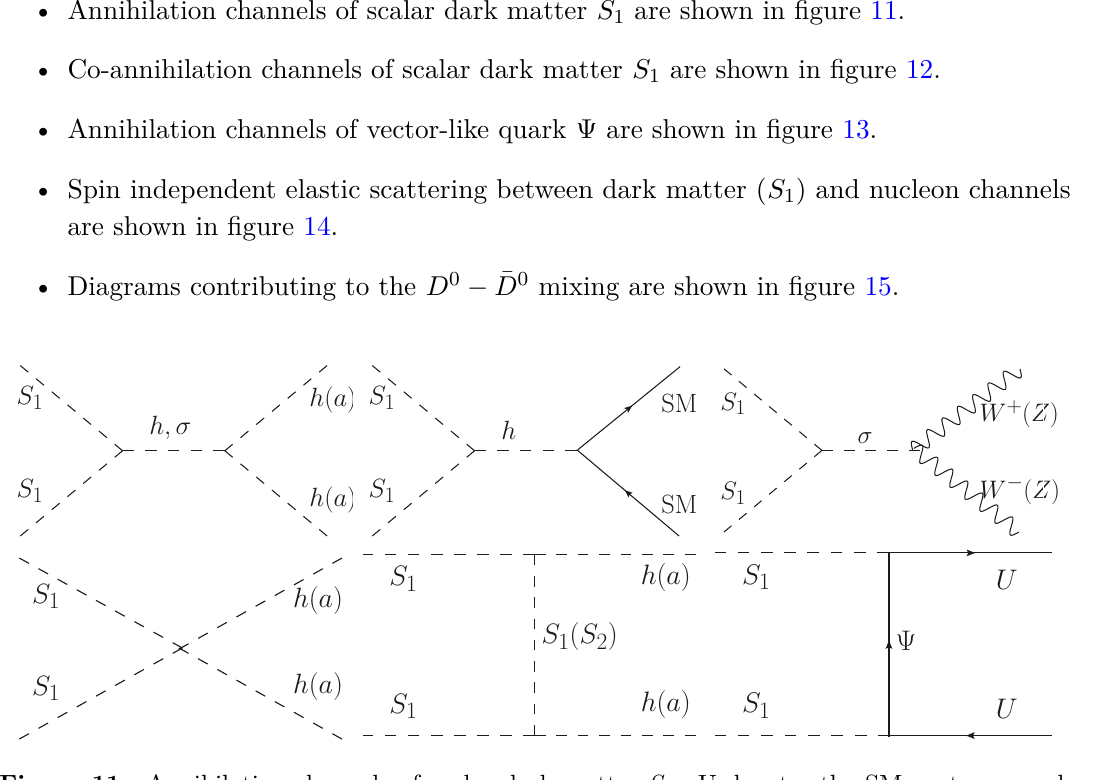
Figure 11. Annihilation channels of scalar dark matter S 1 . U denotes the SM up-type quark ( U ≡ u, c, t, ¯ u, ¯ c, ¯ t